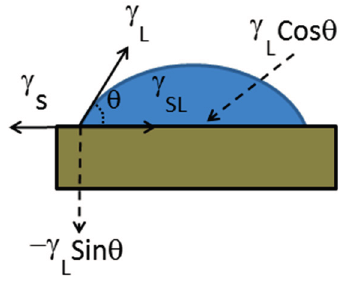
Figure 17. Various surface tension vectors acting on a droplet with a contact angle θ